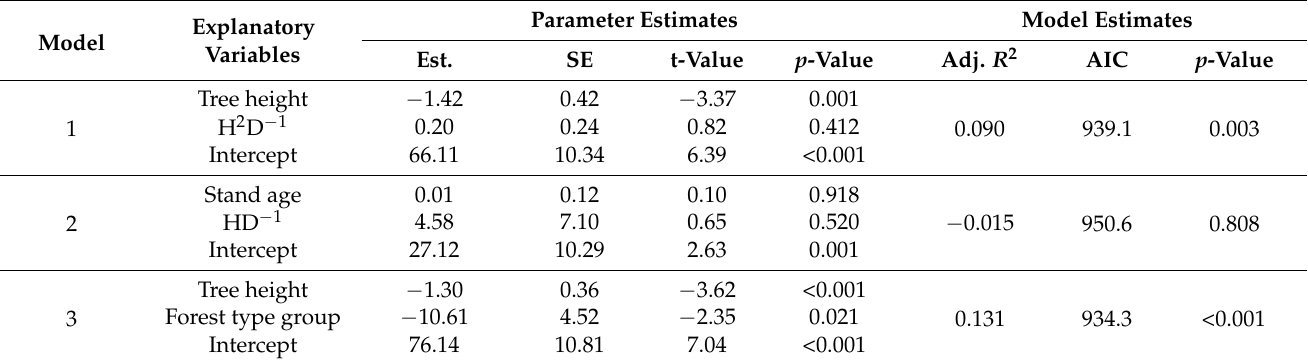
Table 3. Parameter and model estimates of the relative snapping height models.